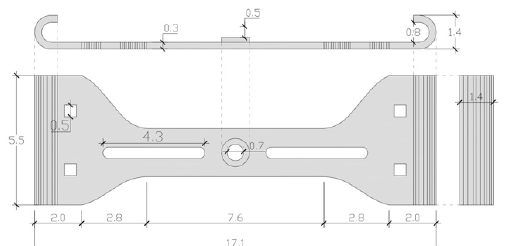
Figure 2. Technical drawing of the employed support.